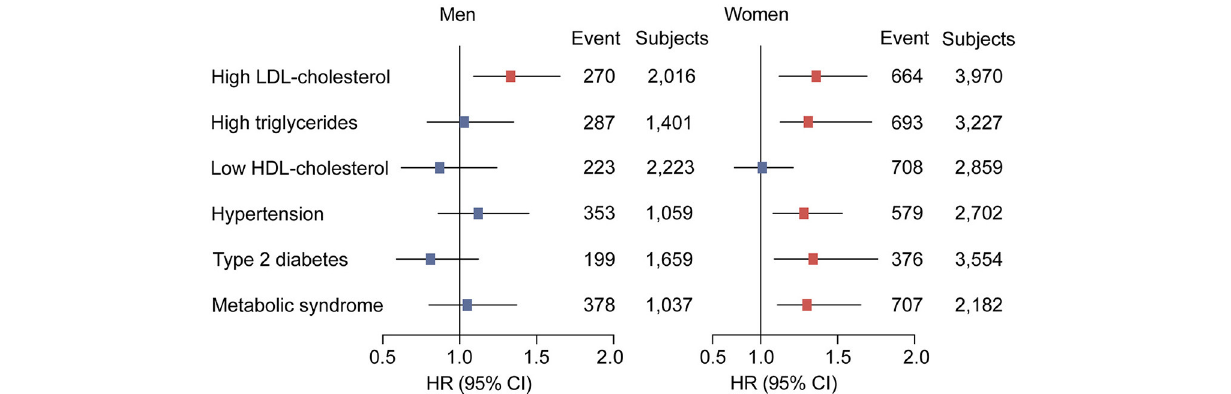
Frontiers in Cardiovascular Medicine |